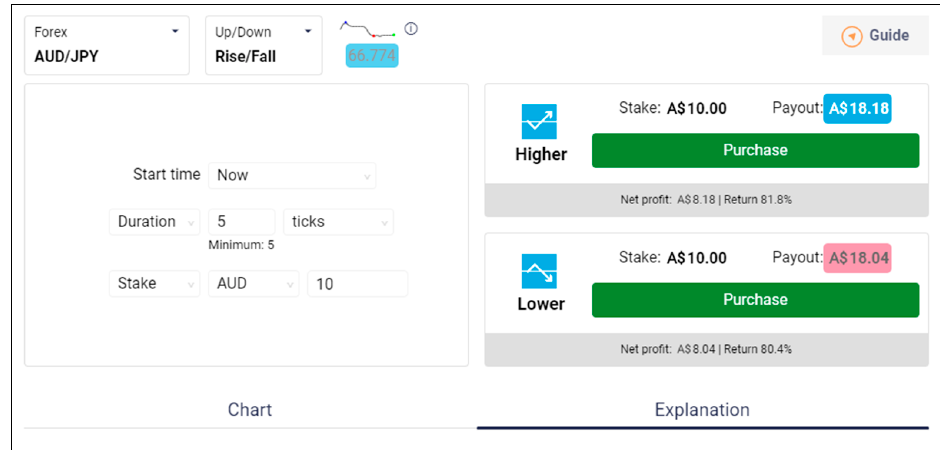
Figure 16. Explanatory screen binary bet. Source: Authors’ processing is based on data available on binary.com (accessed on 17 September 2020).